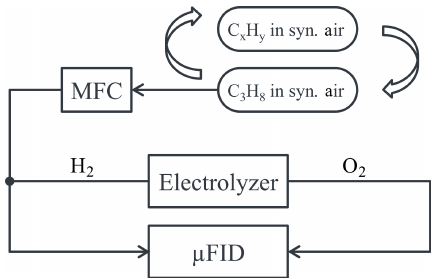
Figure 7. Schematic drawing of the setup to determine the response factors of different hydrocarbons of the µFID.